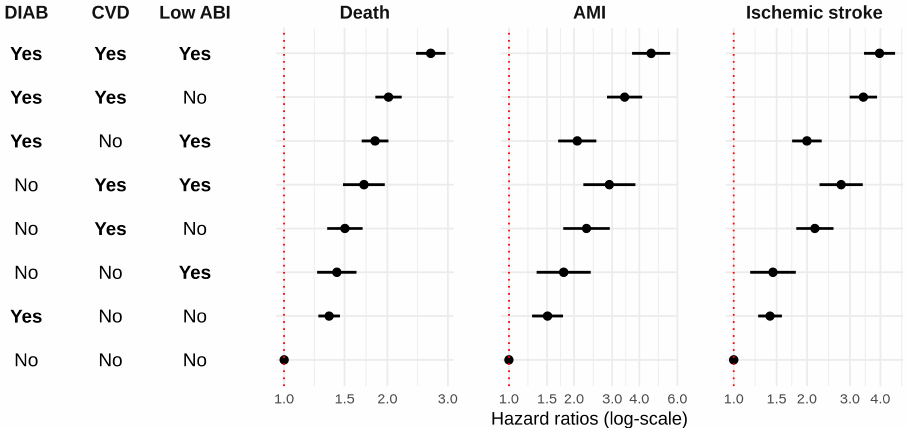
Figure 2. Hazard ratios and 95% confidence intervals for all-cause mortality, acute myocardial infarction, and ischemic stroke by groups of exposure. ABI indicates ankle–brachial index; AMI, acute myocardial infarction; CVD previous cardiovascular disease; DIAB, diabetes.